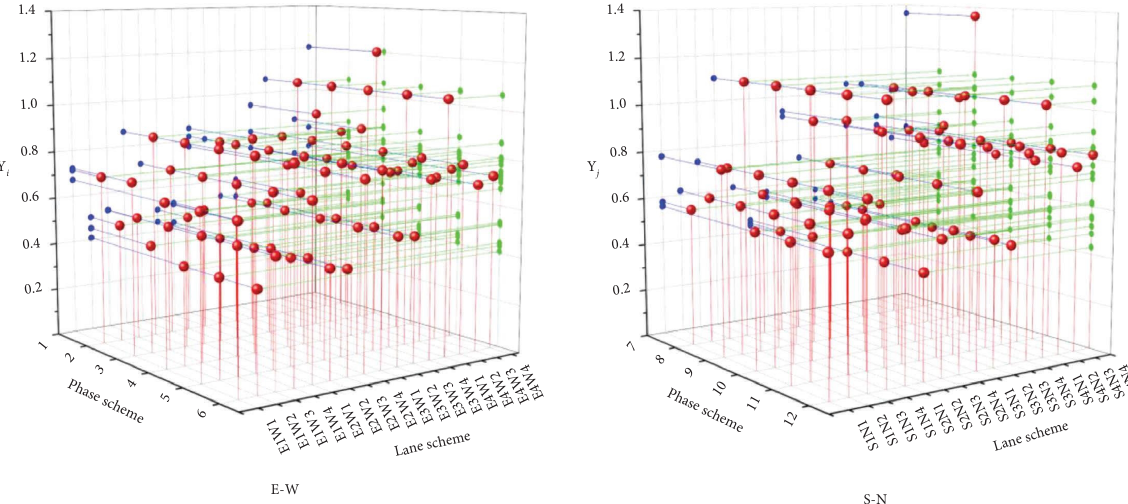
Figure 11: Calculation results of optimal lane and phase schemes in time period 13. (a) E-W. (b)